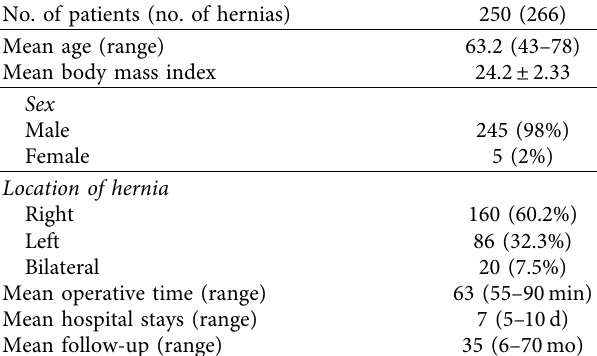
Table 1: Demographics and hernia characteristics of the